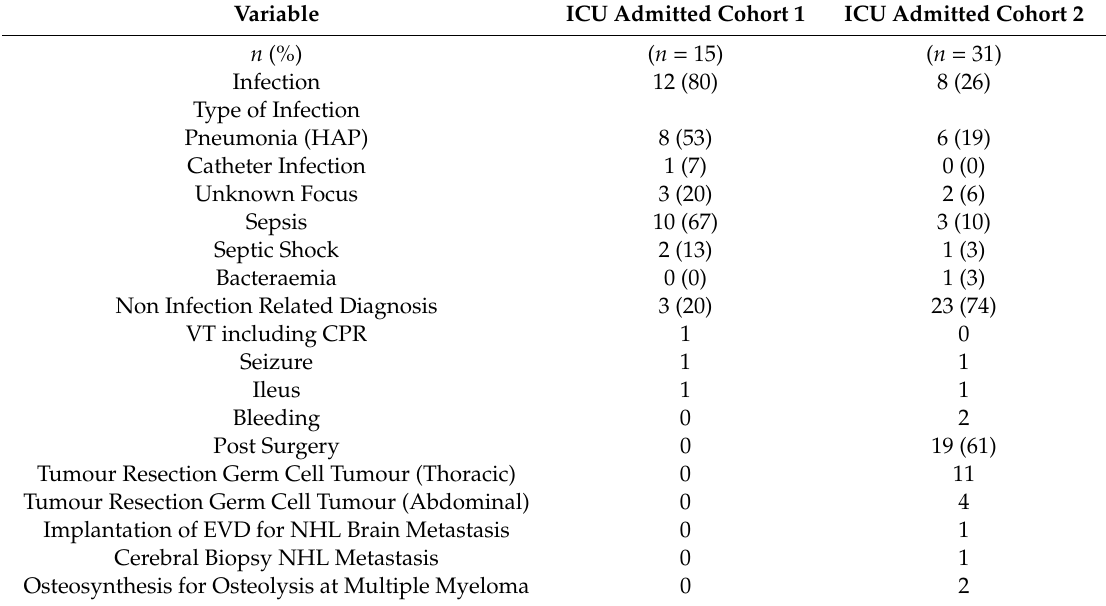
Table 4. Reason for admission and infection focus in patients admitted to the ICU. Cohort 1: patients admitted to the ICU due to immediate complications during HDT and ASCT treatment. Cohort 2 patient admitted within 6 months after high dose chemotherapy and ASCT (excluding cohort 1